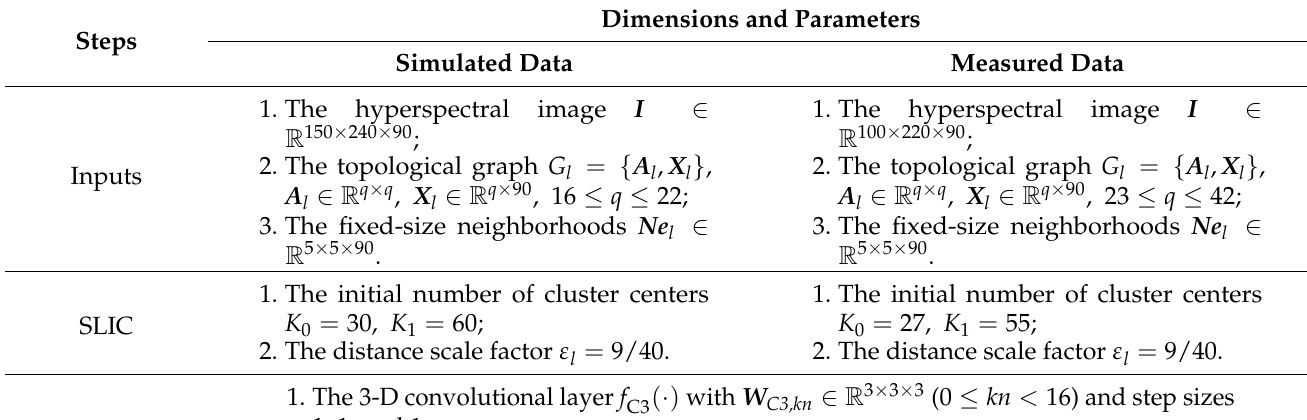
Table 2. The table of dimensions and parameters in the proposed method on the simulated data.